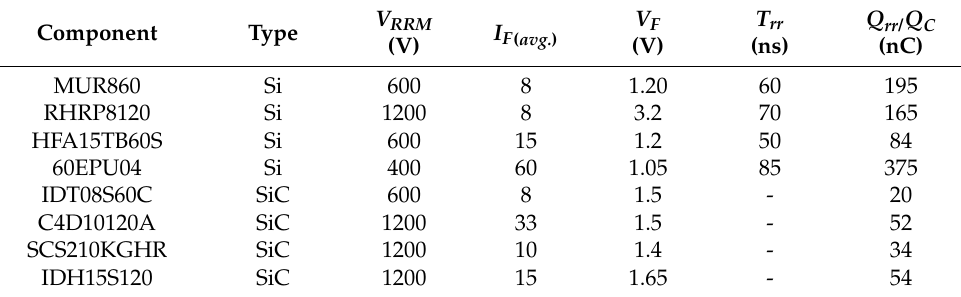
Table 2. Comparison of the characteristics of different diodes.